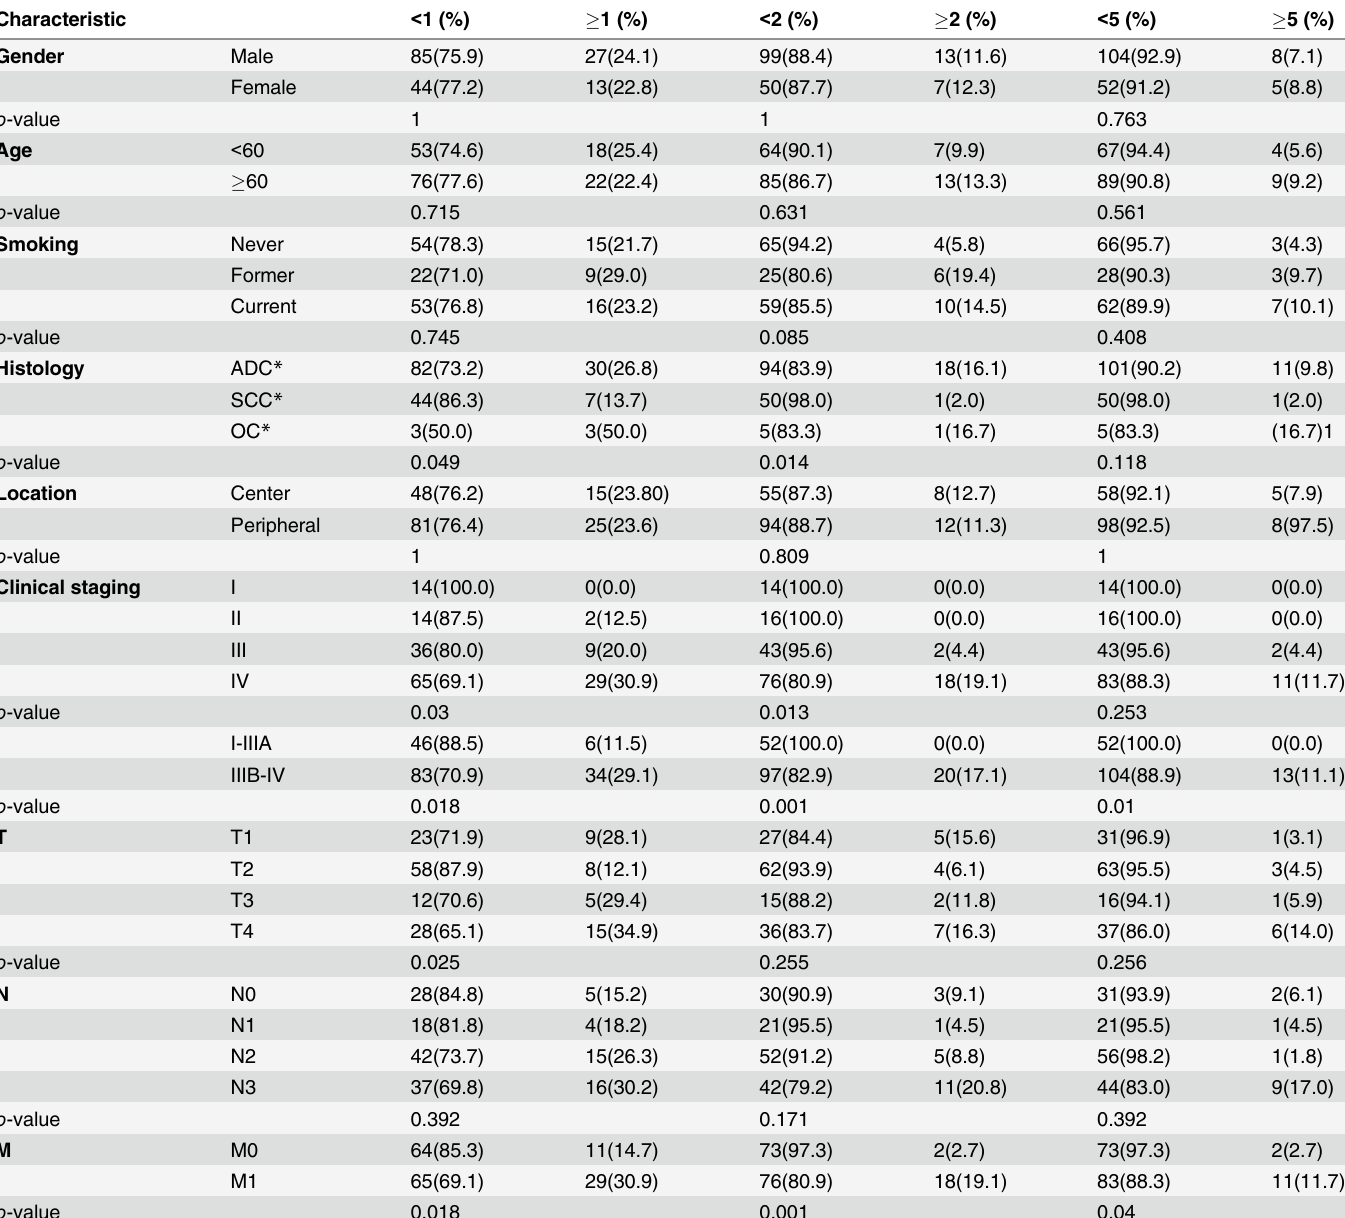
Table 2. Univariate analysis between CTC count (per 7.5 mL of peripheral blood) and clinico-pathological data.